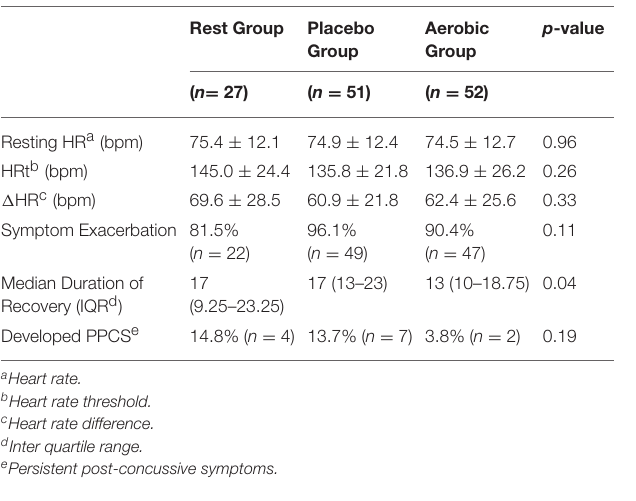
TABLE 2 | Buffalo concussion treadmill test results.